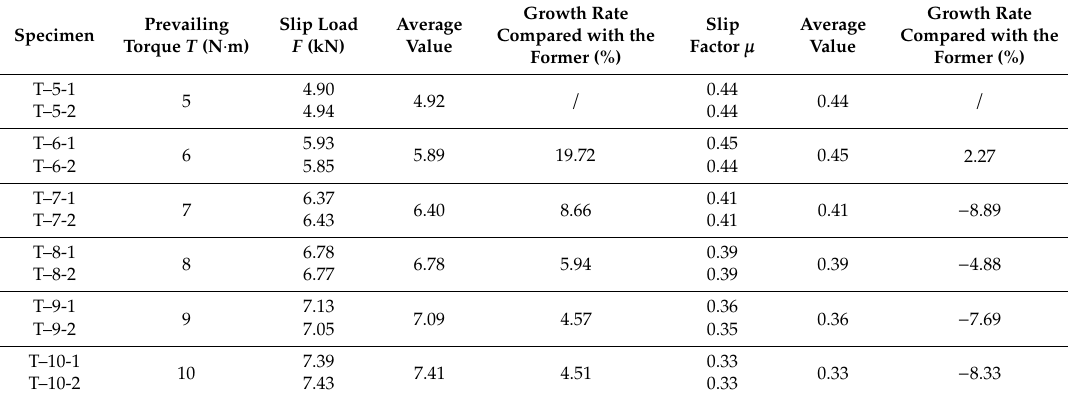
Table 9. The slip load and factor values of tested connections with different prevailing torques.